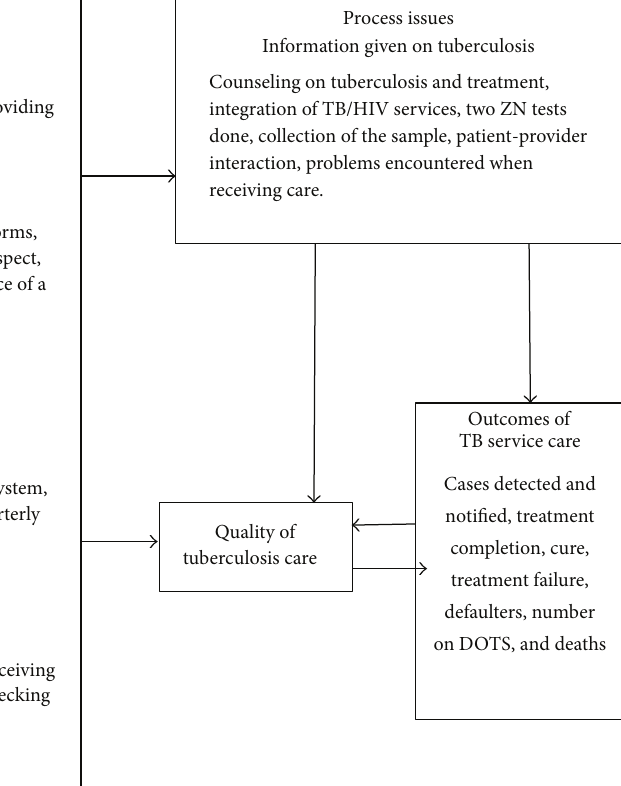
Figure 1: Conceptual frame work for quality of TB service in Kamuli district: adopted from the Donabedian model of quality of health care.